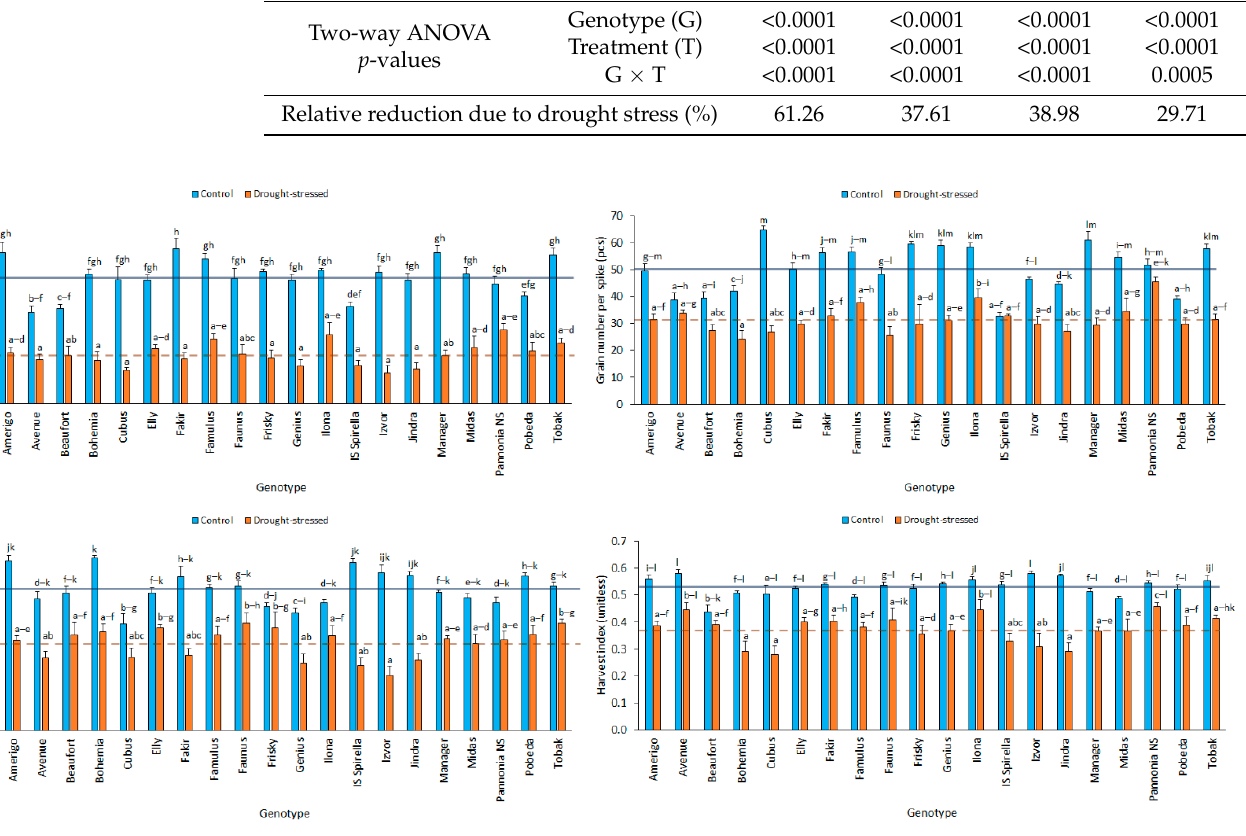
Figure 3. Drought-induced relative reductions (%) in GWS, GNS, TGW, and HI per genotype. 3.2. GNS of Winter Wheat Genotypes under Control and Drought Stress Treatments The relative decline in the mean GNS value under drought stress was 37.61% (Table 2). There were statistically significant differences among the drought stress and control treatments for all tested winter wheat genotypes, except for Avenue, IS Spirella, and Pan- nonia NS (Figure 2). Drought stress treatment and the genotype exerted statistically sig- nificant effects on GNS values (Figure 2). The mean GNS of the genotypes Fakir, Famulus,